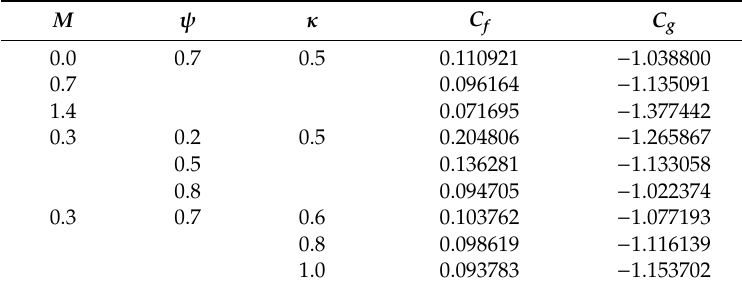
Table 1. Results of C f and C g against M , ψ , and κ .